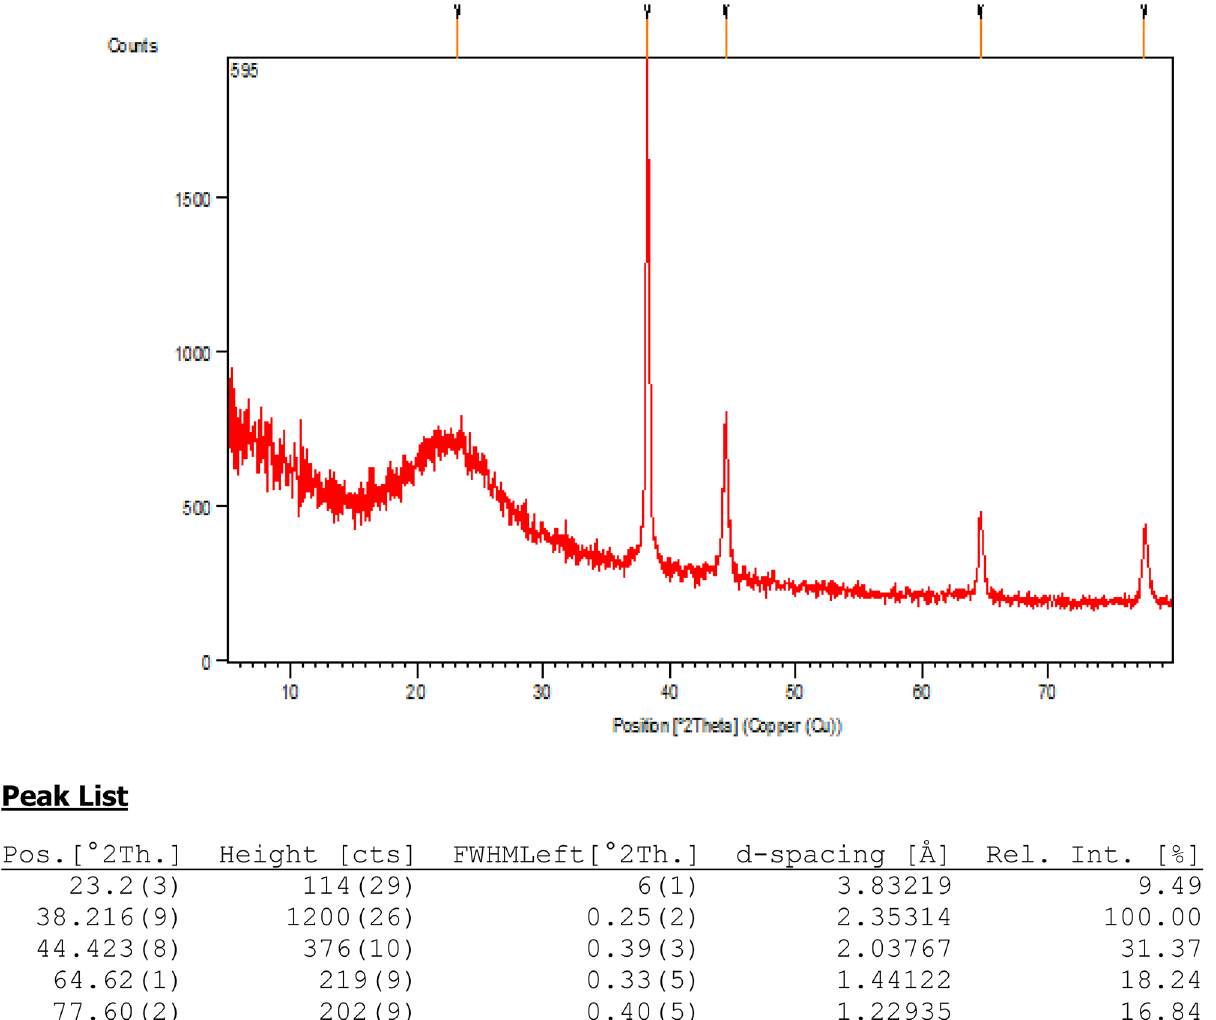
Figure 7. XRD pattern of the KIT-5-biguanidine-Au (0) nanocomposite and its peak